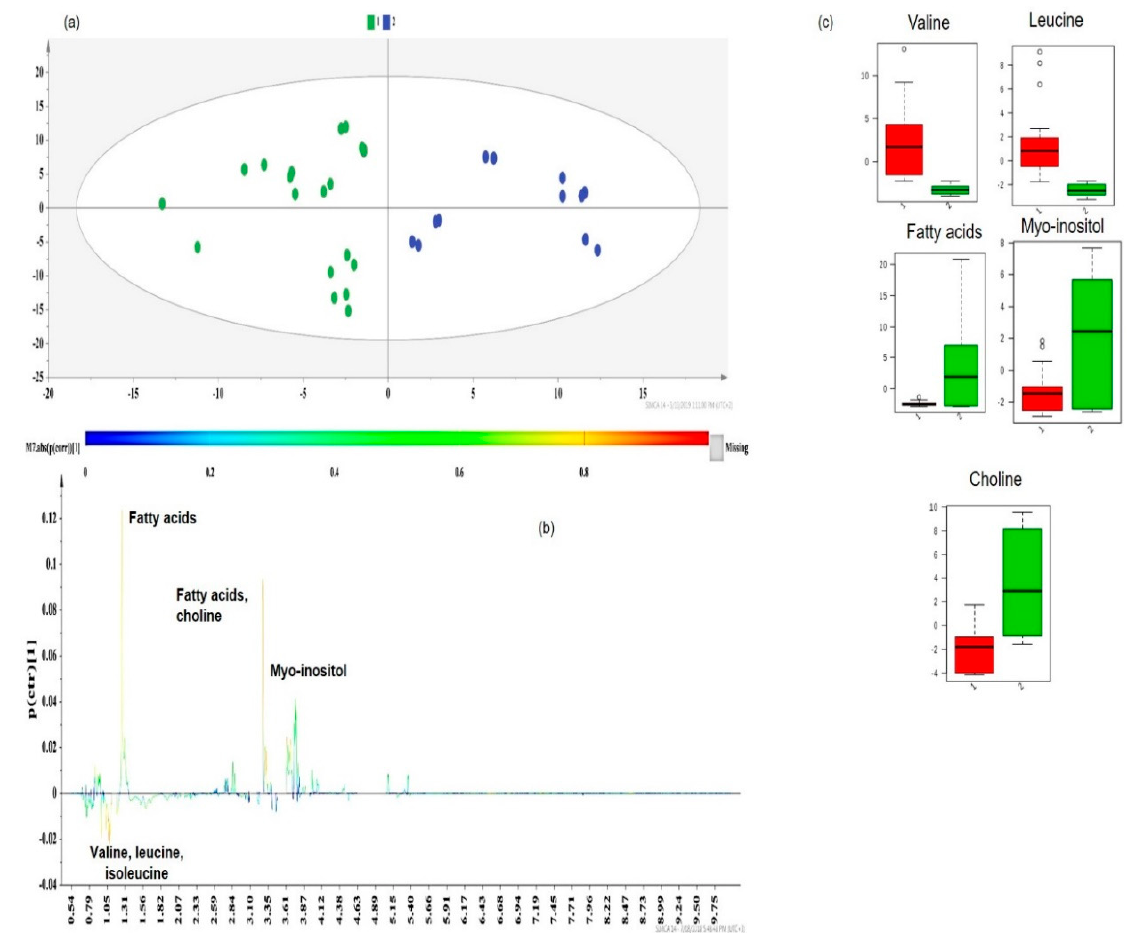
Figure 9. ( a ) OPLS-DA model of Group 1 vs. Group 2 DOE apricot extracts, Pareto scaled, where A = 1 + 1 + 0 (N = 31, R 2 Y(cum) = 0.725, Q 2 (cum) = 0.630, p < 0.05), green dots = apricot pulp samples with a low extraction yield ( ≤ 5 mg carotenoids 100 g − 1 dry sample), and blue dots = apricot pulp samples with a medium extraction yield (5–15 mg carotenoids 100 g − 1 dry sample); ( b ) S-line plot of the OPLS-DA model; ( c ) box-plots of the discriminant metabolites, where red box-plots correspond to Group 1 (green dots) and green box-plots correspond to Group 2 (blue dots).